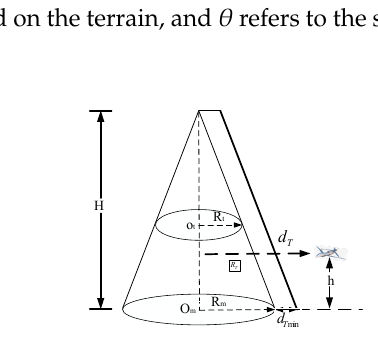
Figure 6. Terrain threat map.